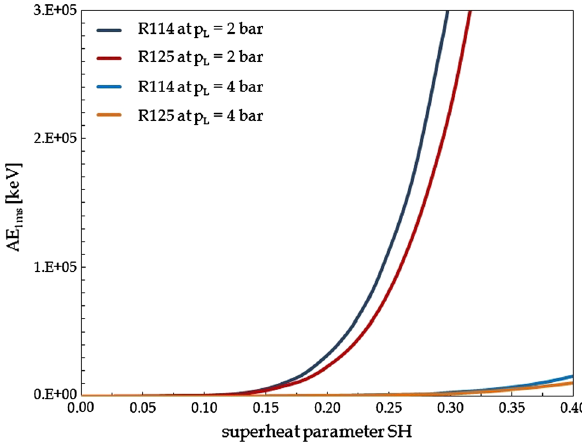
Fig. 7 Distributions of AE 1ms vs. SH using p L as a parameter